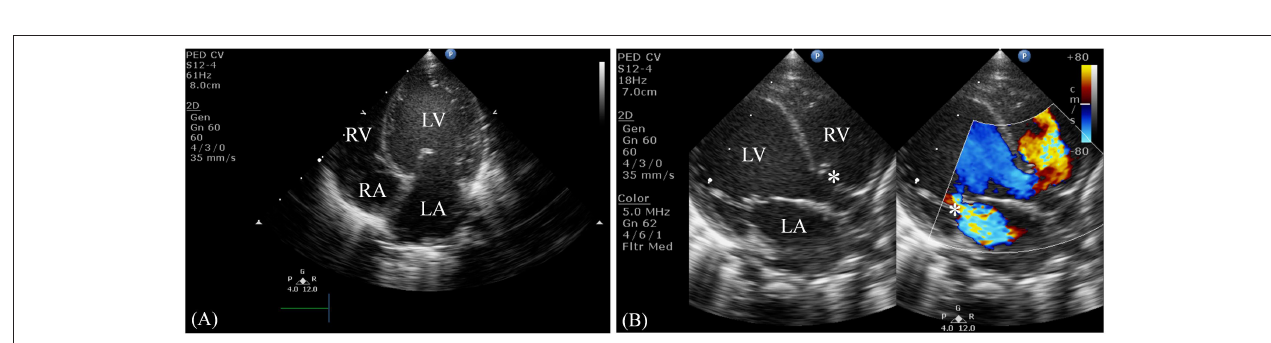
FIGURE 4 | Two-dimensional echocardiogram. (A) This apical four-chamber view shows dilation of the left ventricle and atrium. (B) This parasternal long-axis view demonstrates a non-restrictive perimembranous-outlet type VSD sized 0.471cm (indicated by the left white asterisk) and moderate mitral valve regurgitation (indicated by the right white asterisk). LV, left ventricle; RV, right ventricle; LA, left atrium; RA, right